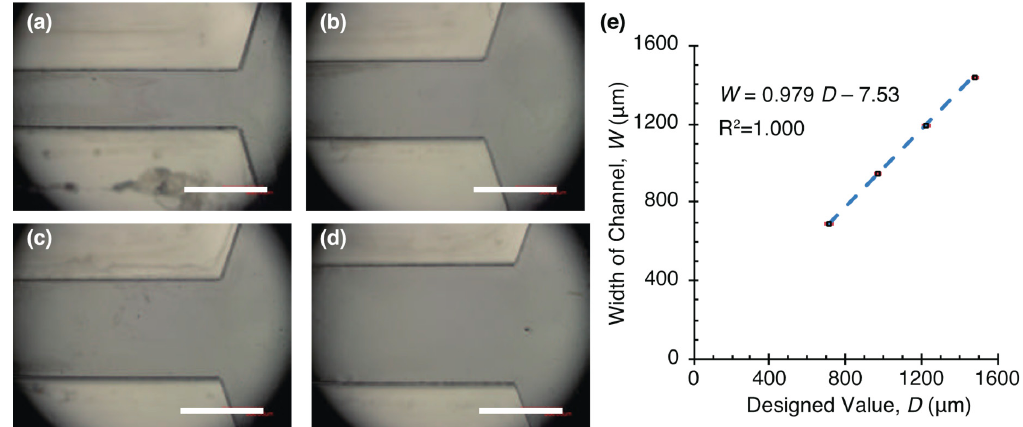
Figure 6. Fabrication of thick SU-8 molds for an open-top microchamber. Microscope image of channels with widths of ( a ) 714 μ m, ( b ) 969 μ m, ( c ) 1225 μ m, and ( d ) 1480 μ m. Scale bars: 1 mm. ( e ) Actual widths of SU-8 channels versus designed values.